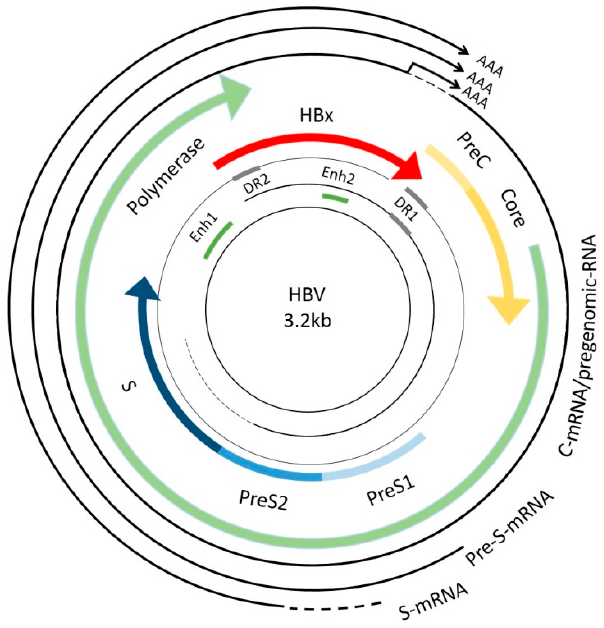
Figure 1. Hepatitis B virus (HBV) genome map. The genome of HBV is a double-stranded DNA (3.2 kb), which contains four overlapping open reading frames (ORFs) coding for viral envelope (pre-S1/pre-S2/S) (blue arrow), core proteins (pre-C/C) (yellow arrow), viral polymerase (green arrow), and HBx protein (red arrow). The genome contains four promoters, two enhancer regions (Enh1, Enh2), and two direct repeats (DR1, DR2).